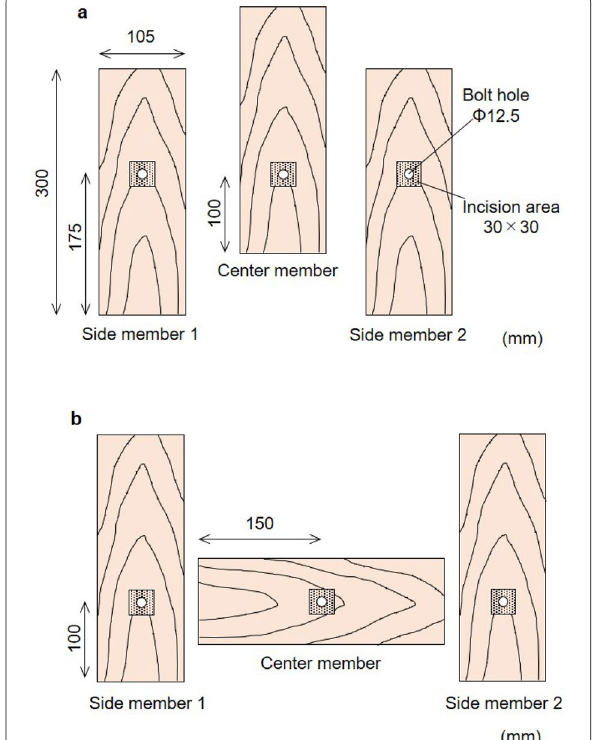
Fig. 2 Incision area treated around bolt holes. a Groups loaded parallel to the grain. b Groups loaded perpendicular to the